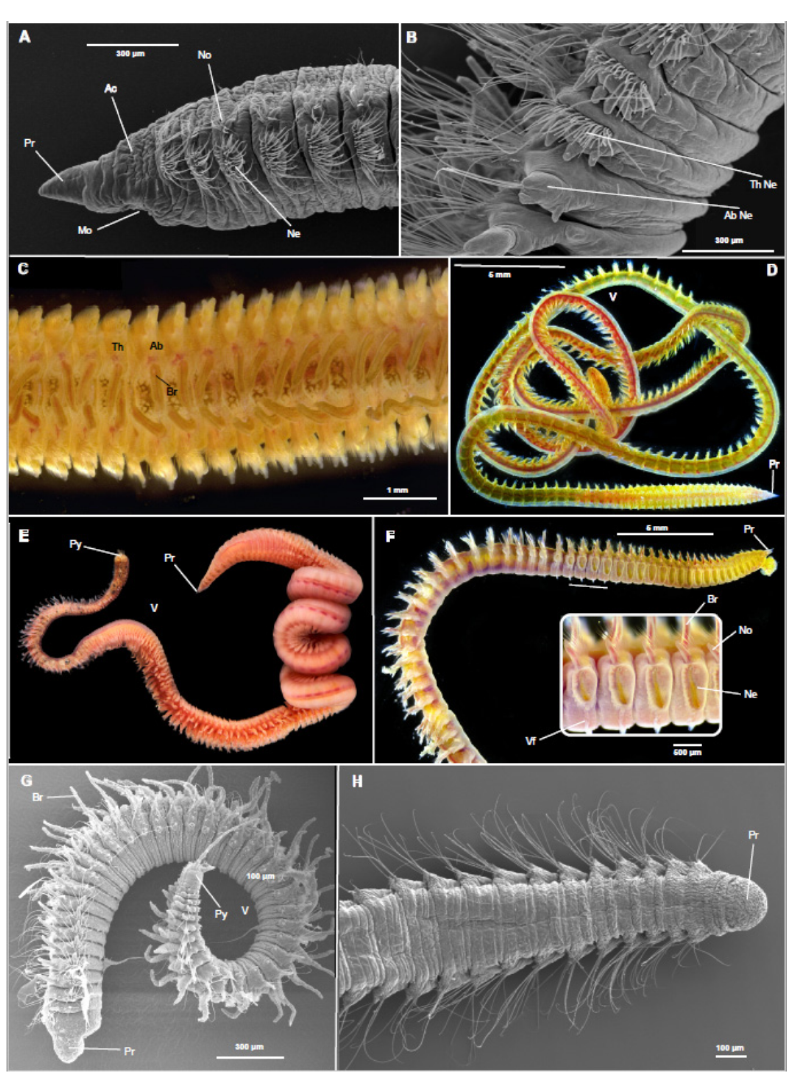
Figure 5. Scanning electron microscopy (SEM) and light microscopy images of different orbiniids. ( A ). Scoloplos armiger , anterior end. ( B ). Orbinia cf. armandi , transition thorax-abdomen. ( C ). Naineris laevigata , detail of the dorsum with branchiae. ( D ). Leodamas chevalieri , general view of a living specimen. ( E ). Scoloplos armiger , general view of a living specimen. ( F ). Phylo kuwaitica , anterior-mid body view of a living specimen and detail of posterior thoracic chaetigers. ( G ). Pettibonella multiuncinata , general view. ( H ). Orbiniella sp., dorsum of the anterior end. Ab. Abdomen; Ab Ne. Abdominal Neuropodium; Ac. Achaetous ring; Br. Branchiae; Mo. Mouth; Ne. Neuropodium; No. Notopodium; Pr. Prostomium; Py. Pygidium; V. 1478 Ventrum; Vf. Ventral fringe. Photo E is not